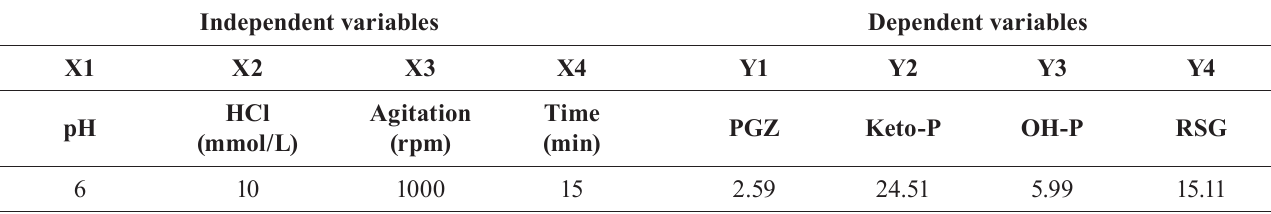
TABLE I - I ndependent (X1, X2, X3, and X4) and recovery factor extraction (%) - dependent variables (Y1, Y2, Y3, and Y4), fractionate factorial design matrix, and results of experimental design for pioglitazone (PGZ) and its metabolites (Keto-P and